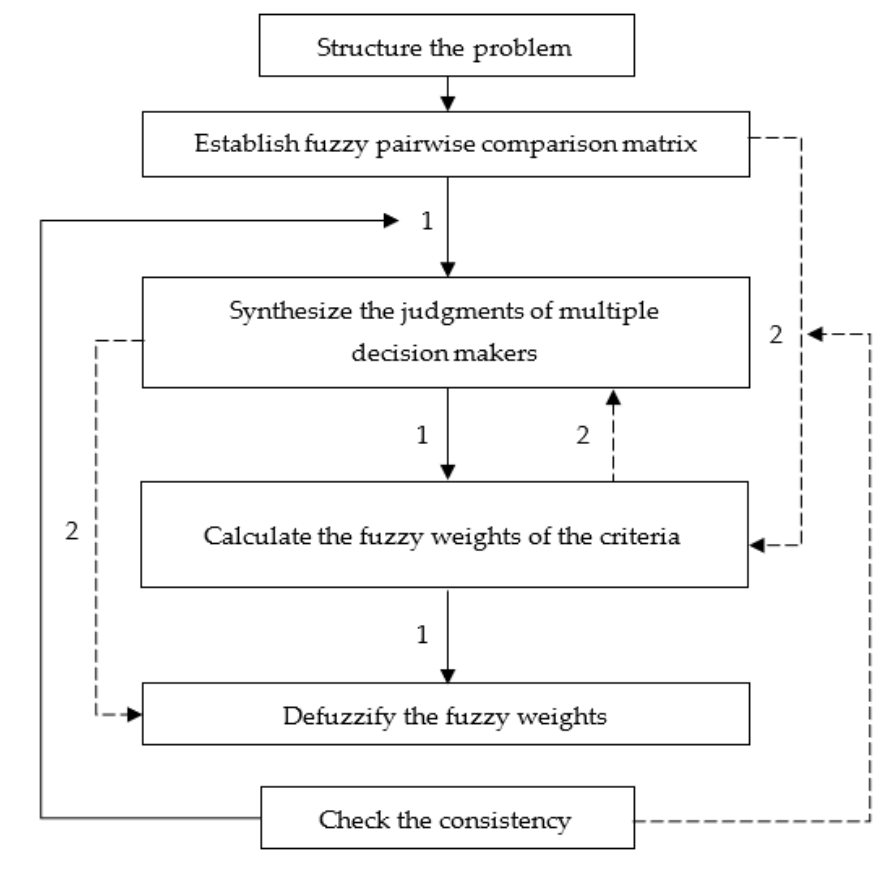
Figure 2. The calculation process of the fuzzy AHP method [33].